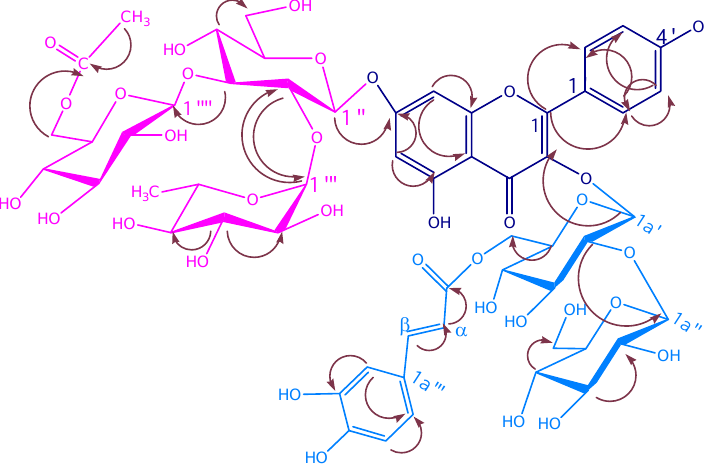
Figure 5. Significant HMBC correlations of KSR3 . Arrows point from H to C.